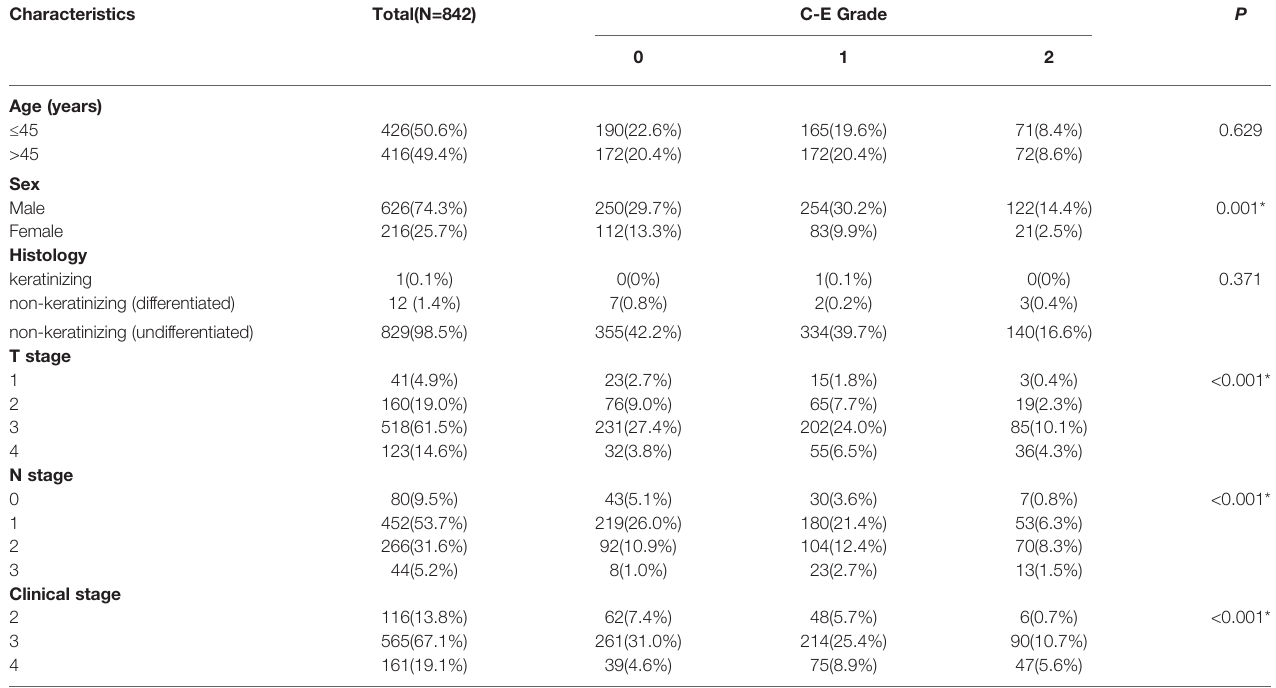
TABLE 1 | The relationship between C-E grade and clinicopathologic characteristics in the whole cohort. Characteristics